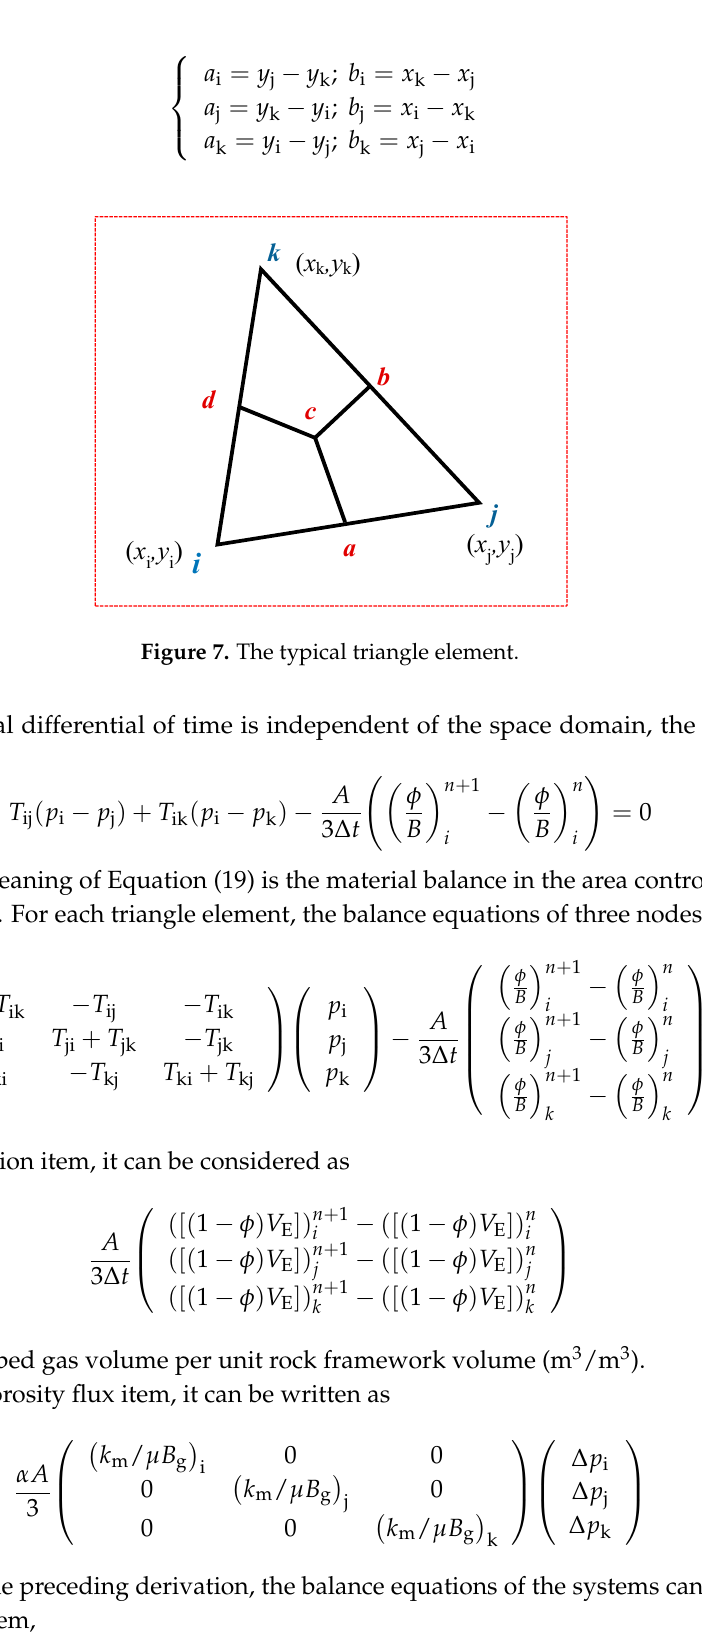
Figure 8. Concise description of the discrete fracture model network (DFN) model.